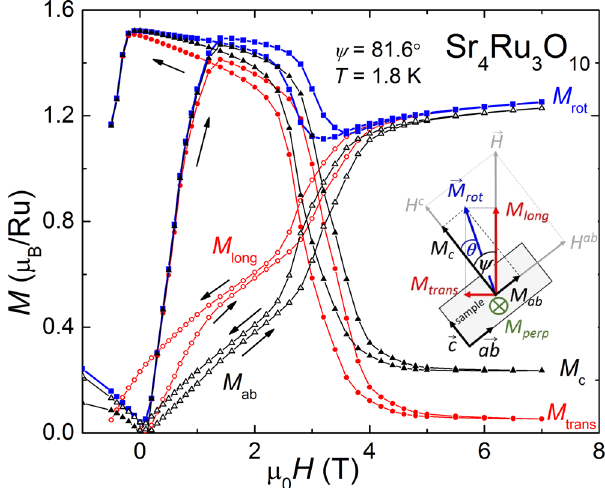
Figure 2. The inset shows a geometrical sketch of the sample Sr 4 Ru 3 O 10 mounted inside the SQUID magnetometer. ψ is the rotation angle of the applied field respect to the magnetic easy c -axis. M long and M trans are measured components of to the applied field in the plane of rotation. The component M perp parallel to the axis of rotation is not captured during the measurement. The main panels compares the different components of the magnetization M long , M trans , M ab , M c , and the modulus M rot versus magnetic field H measured at 1.8 K for ψ =